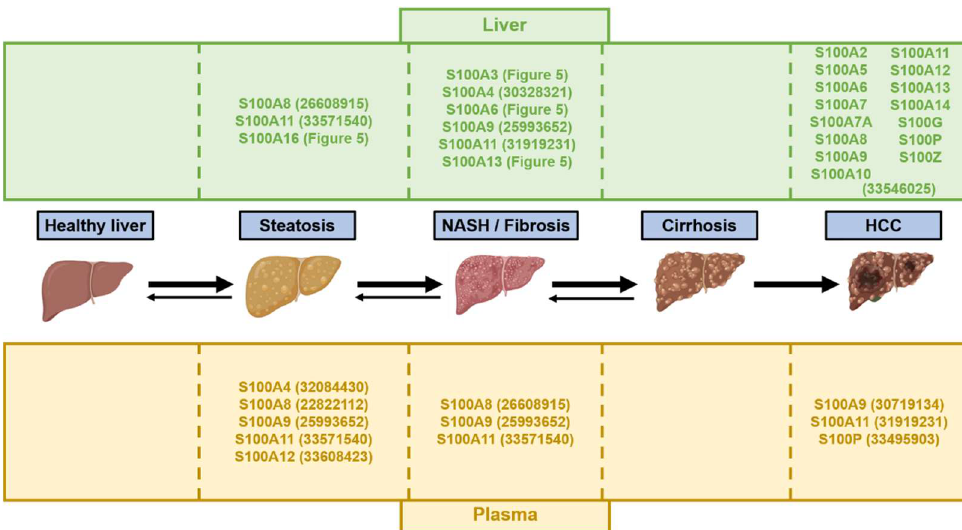
Figure 6. Summary of the main S100 proteins involved in the pathogenesis of NAFLD/NASH and HCC at the different stages of these diseases. The upper panel indicates the S100 proteins known to be upregulated in the liver tissue of rodents and/or humans. The lower panel indicates the main S100 proteins increased in blood samples from rodent and/or humans. The numbers in parentheses refer to the PMID of representative studies supporting the indicated function for S100 protein. Artwork used to construct this figure is freely available from BioRender (https://biorender.com/ (accession on 1 June 2022)).